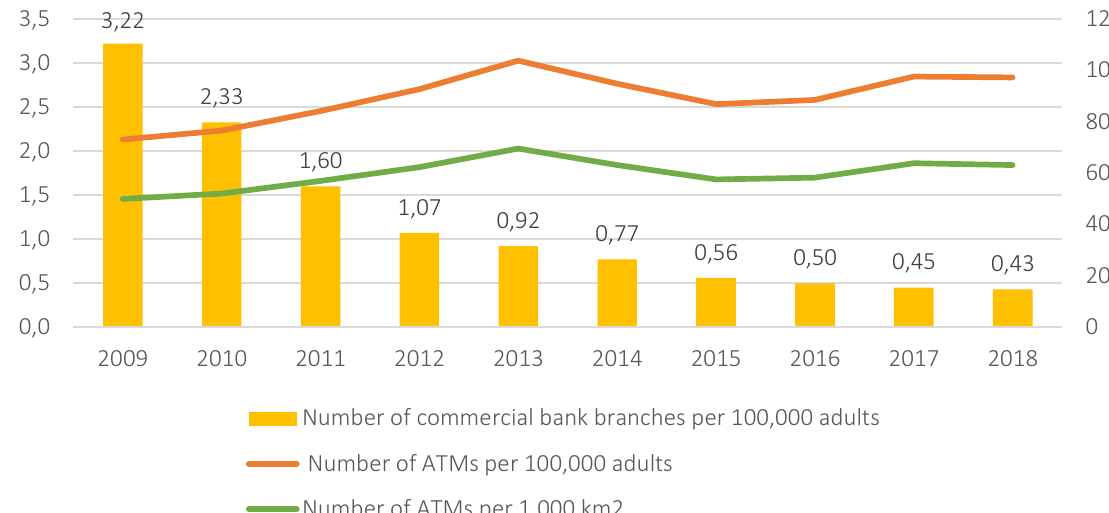
Figure 3 (а). Development of financial services infrastructure in Ukraine in